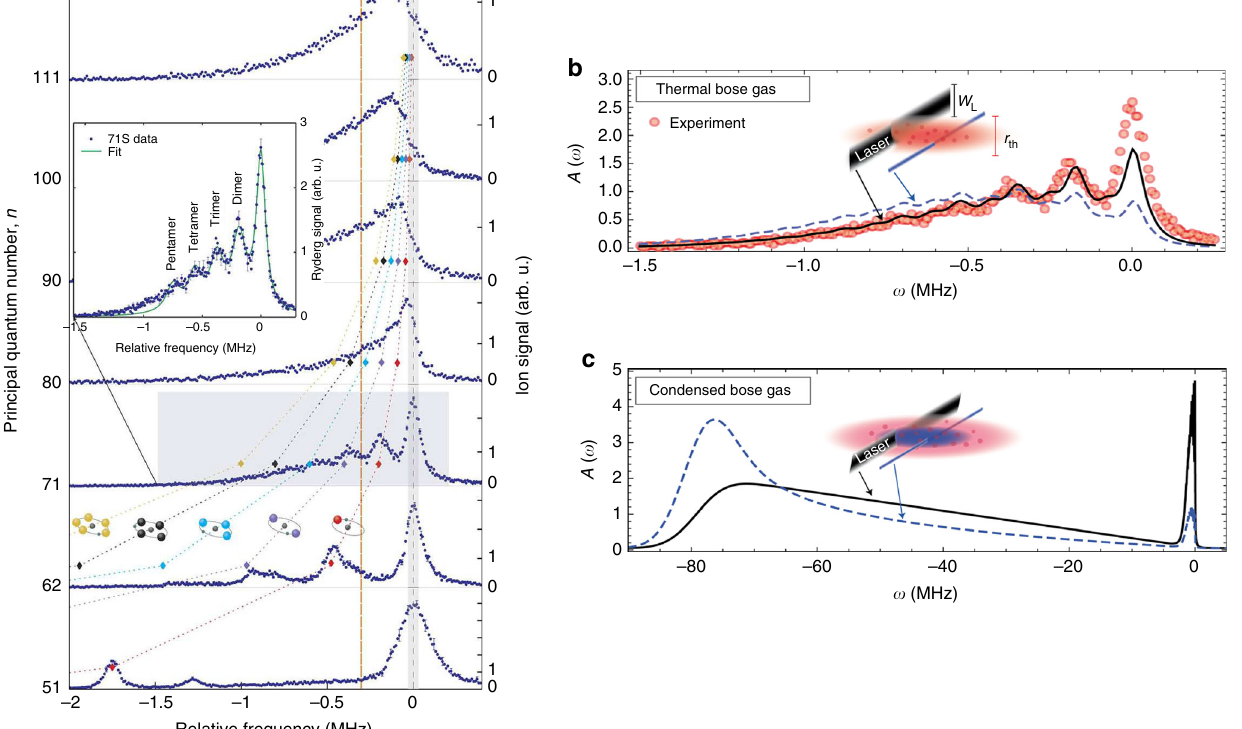
Fig. 6 Polyatomic Rb molecules and many-body spectra. a The observation of polyatomic s -wave Rydberg molecules (dimers, trimers, and tetramers) in photoassociation of Rydberg molecules; fi gure reprinted from ref. 73 , b density averaged absorption spectra for Rb(71s) excitations. In a , the gas is thermal at T = 0.5 μ K and the MOT center density is ρ = 1.7 × 10 12 cm − 3 . The laser pro fi le illuminates the cloud over the full cylindrical radius (black) and in a small waist (dashed, blue); data is reported in Gaj et al. 73 . In b , the density averaged absorption spectrum at T / T c = 0.47 for a partially condensed gas of (zero temperature) at peak density ρ = 2.3 × 10 14 cm − 3 . Reprinted fi gure with permission from ref. 77 Copyright (2016) by the American Physical separation in comparison to the extent of the electronic wave momentum Rydberg states are, as shown in Fig. 4, the lifetimes of function. Additionally, the spread of the Rydberg electron wave macrodimers will be on the order of the Rydberg atomic lifetimes. function and the short-range repulsive walls limit ionization. As Calculations for Cs(89d) Rydberg macrodimers gave a liftetime of long as the inner turning point in the bound state potential is ~ 450 μ s, determined entirely by Rydberg atom decay 19 . Measure- − 3 for photoinduced collisions and ments at densities of ~ 10 10 cm outside the region where potentials correlating to high-angular